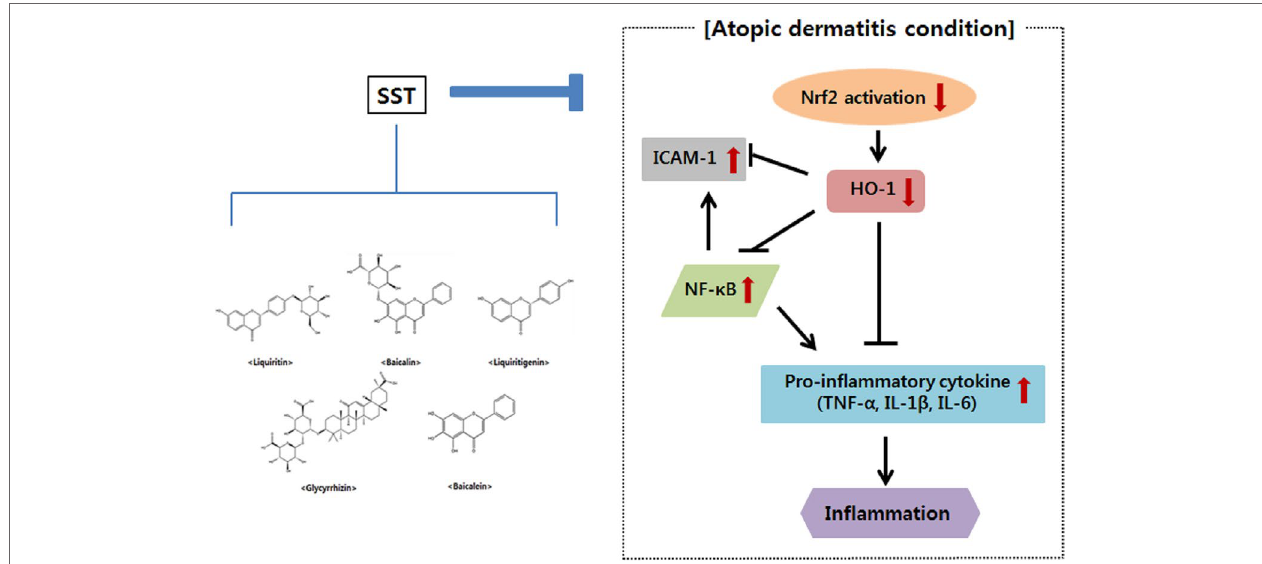
FIGURE 10 | A summary of AD-related genes regulated by SST water